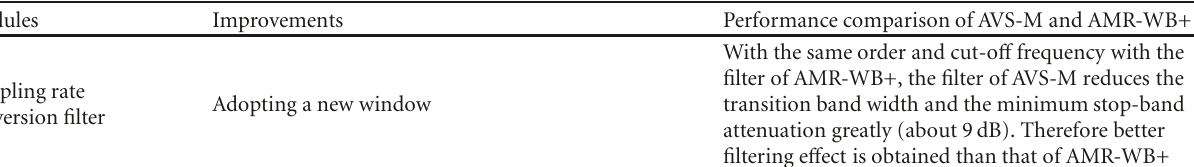
Table 1: The core module comparison of AVS-M and